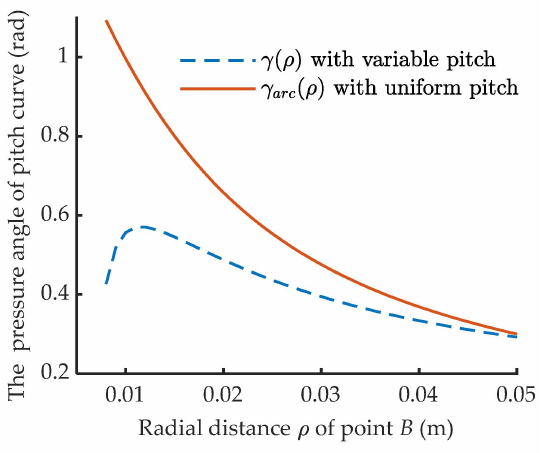
Figure 9. Comparative analysis of pressure angle on the pitch